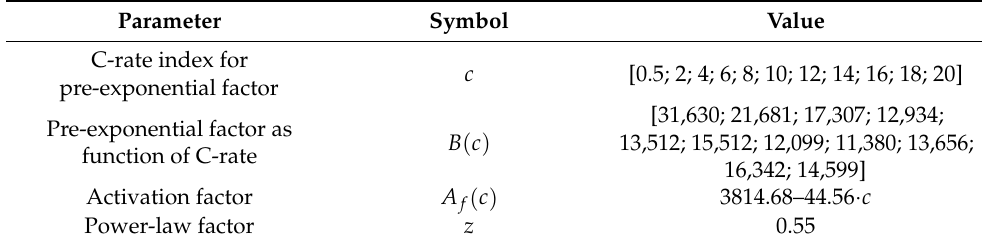
Table 3. Battery ageing parameters for A123 26650 cell [23].